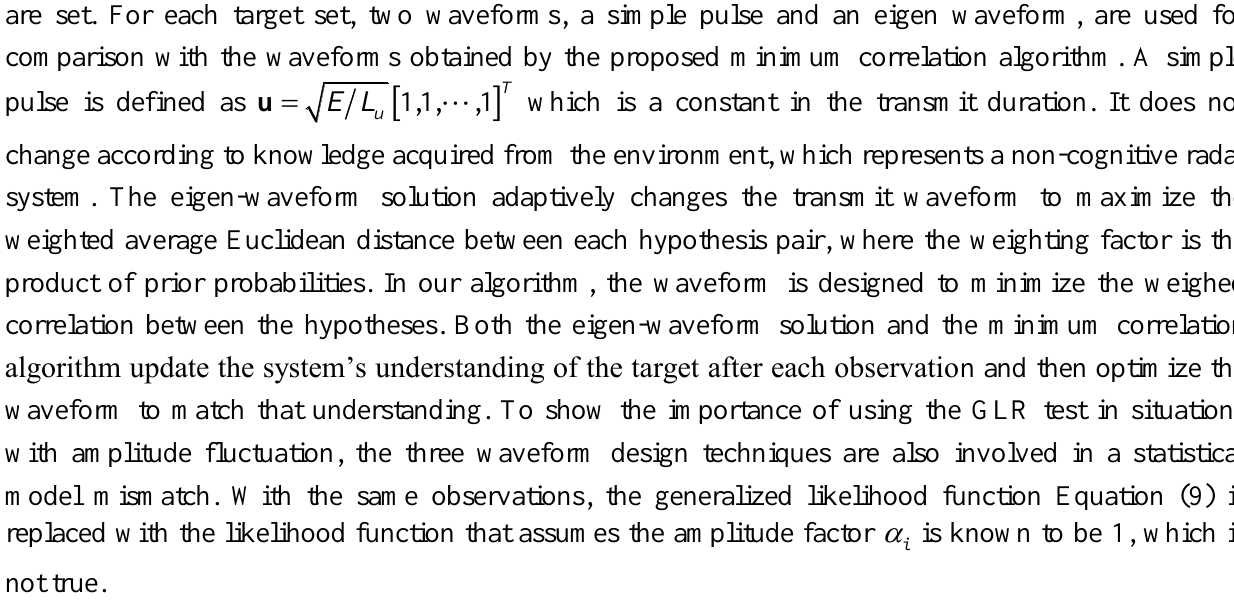
Figure 4. (a) Average number of illuminations to reach a decision and (b) correct recognition rates at the time when a decision has been made vs. energy per illumination for different waveform design